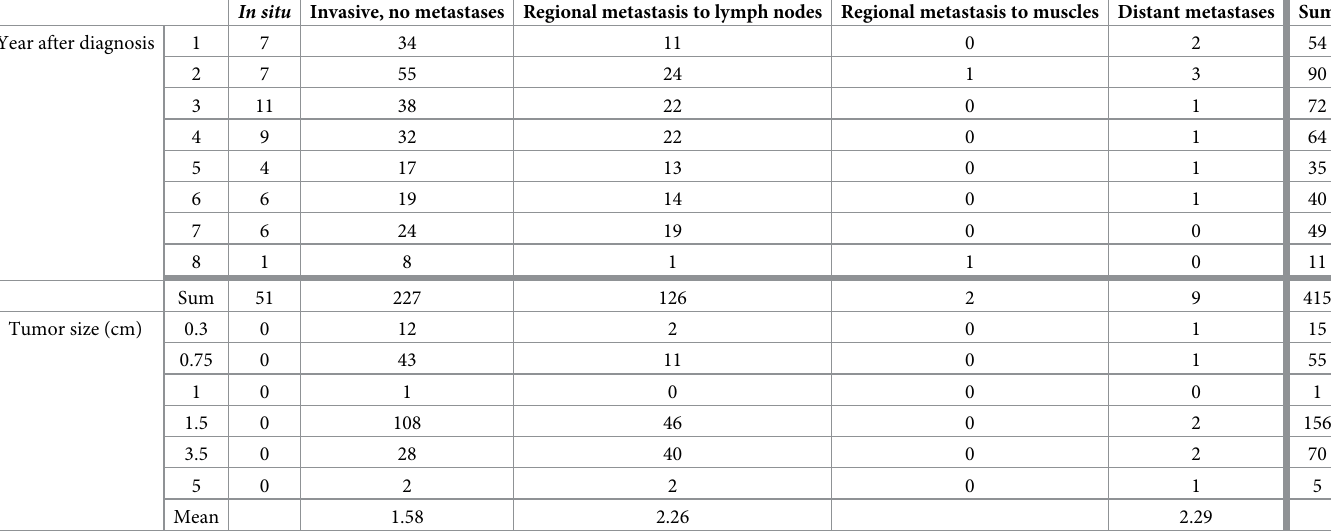
Table 1. Overview of the study population (415 cases), according to breast cancer stage at the time of diagnosis. In situ Invasive, no metastases Regional metastasis to lymph nodes Regional metastasis to muscles Distant metastases Sum